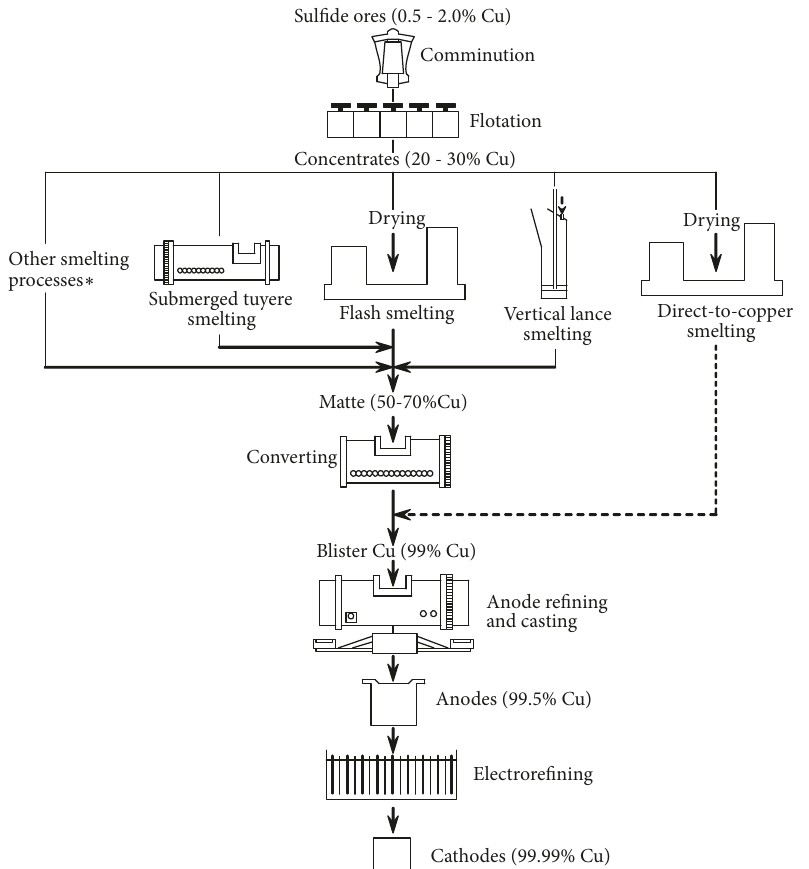
Figure 1: Industrial processing of copper sulphides ore to obtain copper cathodes. (Source: Extractive Metallurgic of Copper, pp.2